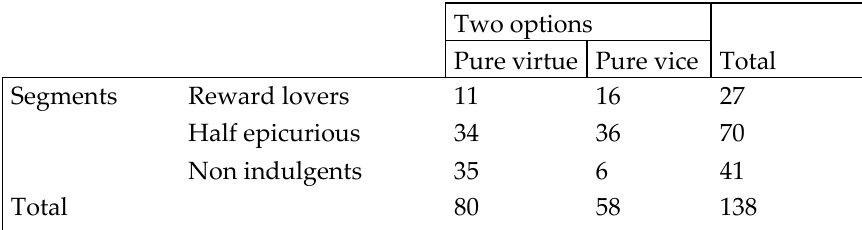
Table A2. Segment’s food choice. Pure virtue-pure vice set (number of respondents).